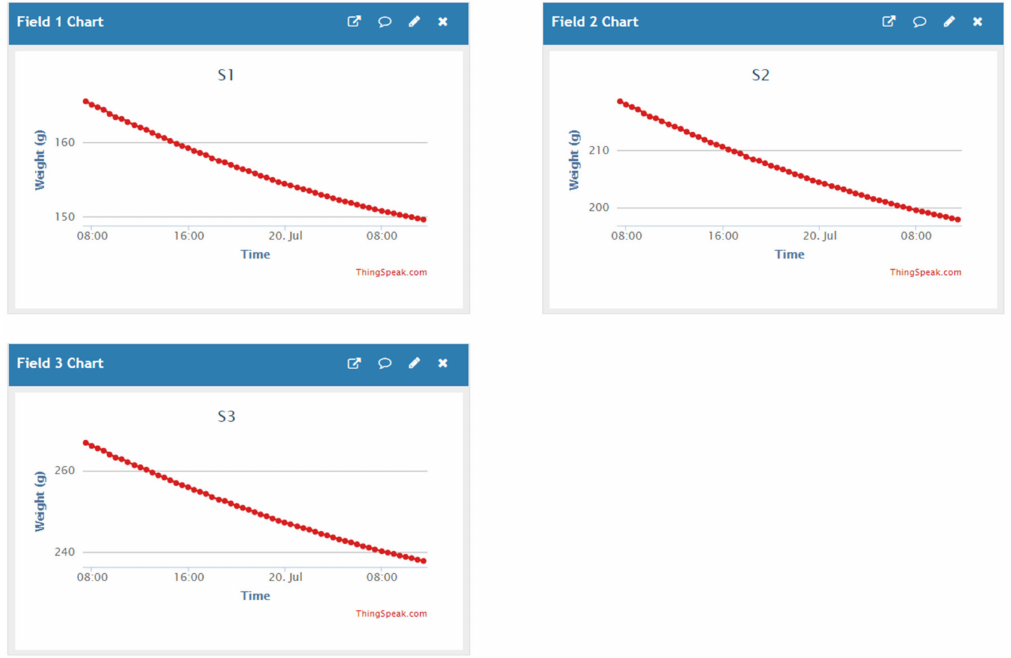
Figure 3. Example of real time data acquisition through ThingSpeak during the sage dehydration process for the three tests conditions (S1 = 3 kg / m 2 ; S2 = 4 kg / m 2 and S3 = 5 kg / m 2